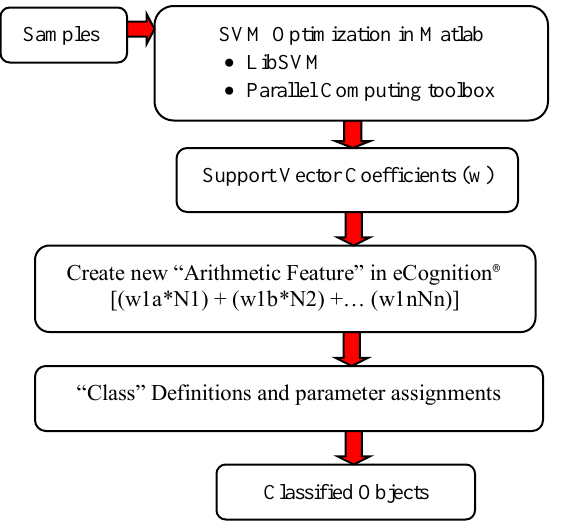
Figure 8. SVM and Rule set development Process Flow